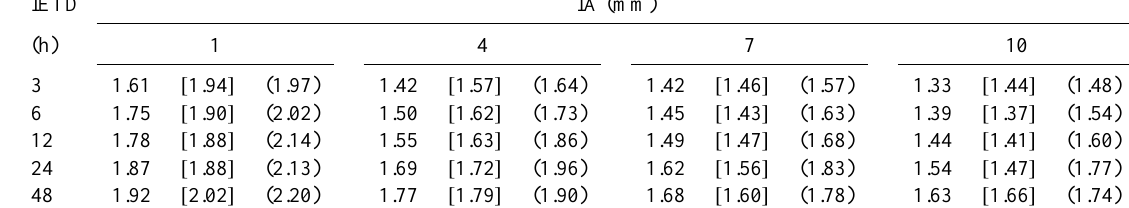
Table 2. Estimations of the dependence parameter ˆ θ for the precipitation series of Brescia, Parma [.], and Naples (.).